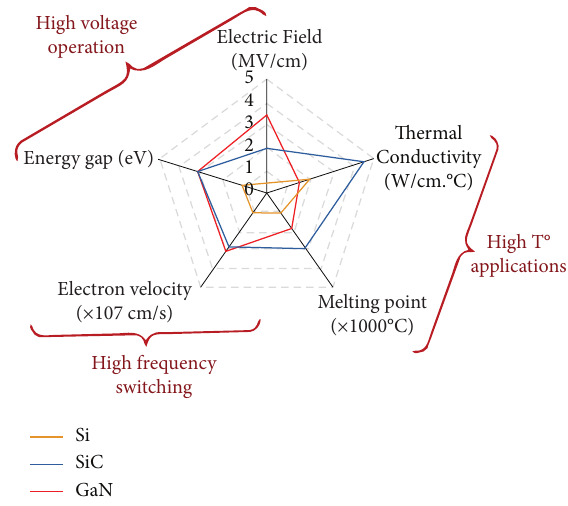
Figure 1: An overview showcasing silicon, silicon carbide, and gallium nitride